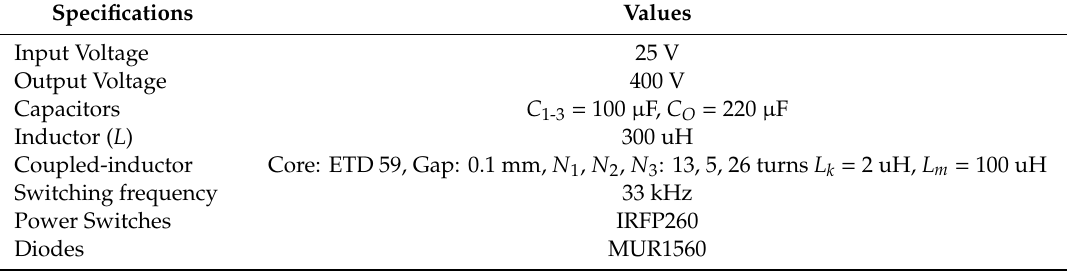
Table 2. The specifications of the implemented circuit.